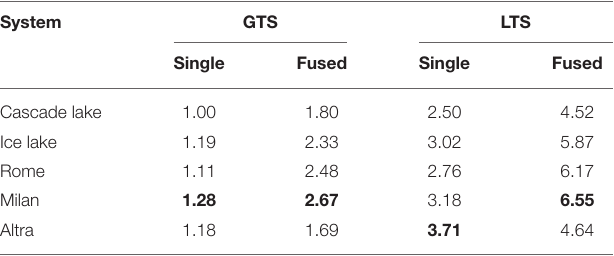
TABLE 6 | Time-to-solution speedups of the studied systems when using different configurations of the solver EDGE. System GTS LTS Single Fused Single Fused Cascade